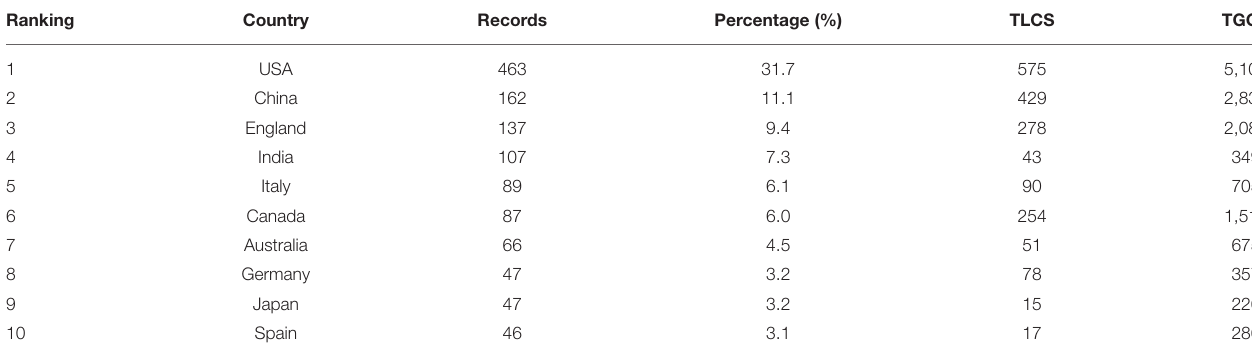
TABLE 3 | Top-10 most productive countries in COVID-19 and